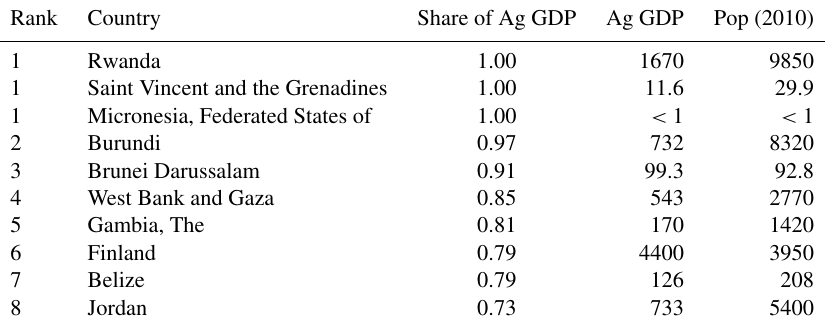
Table B2. Top 10 countries of the largest share of agricultural GDP exposed to dry areas with agricultural GDP (millions of USD) and population (thousands).